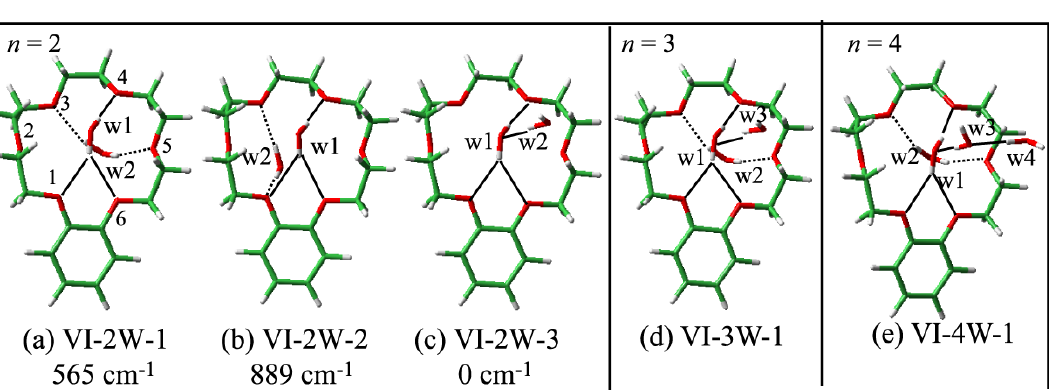
O) , (d) B18C6-(H O) , and (e) 2 2 2 3